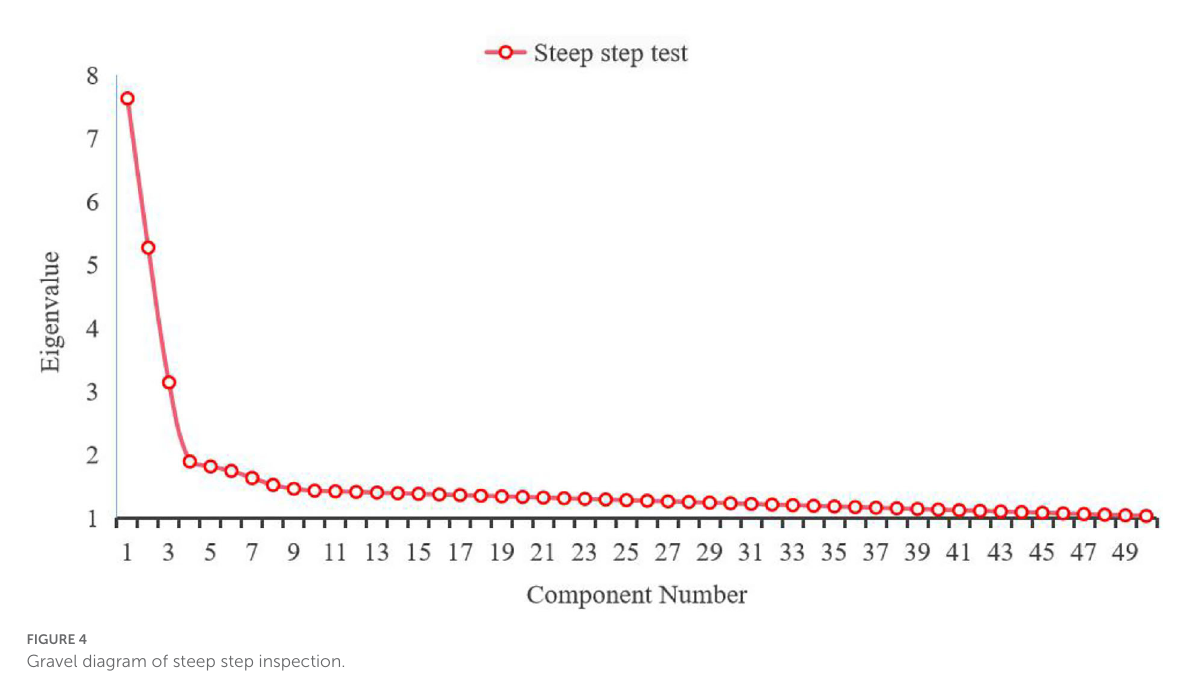
FIGURE4 Gravel diagram of steep step inspection.